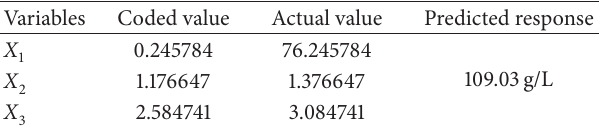
Table 6: Canonical analysis on the coded and actual value.